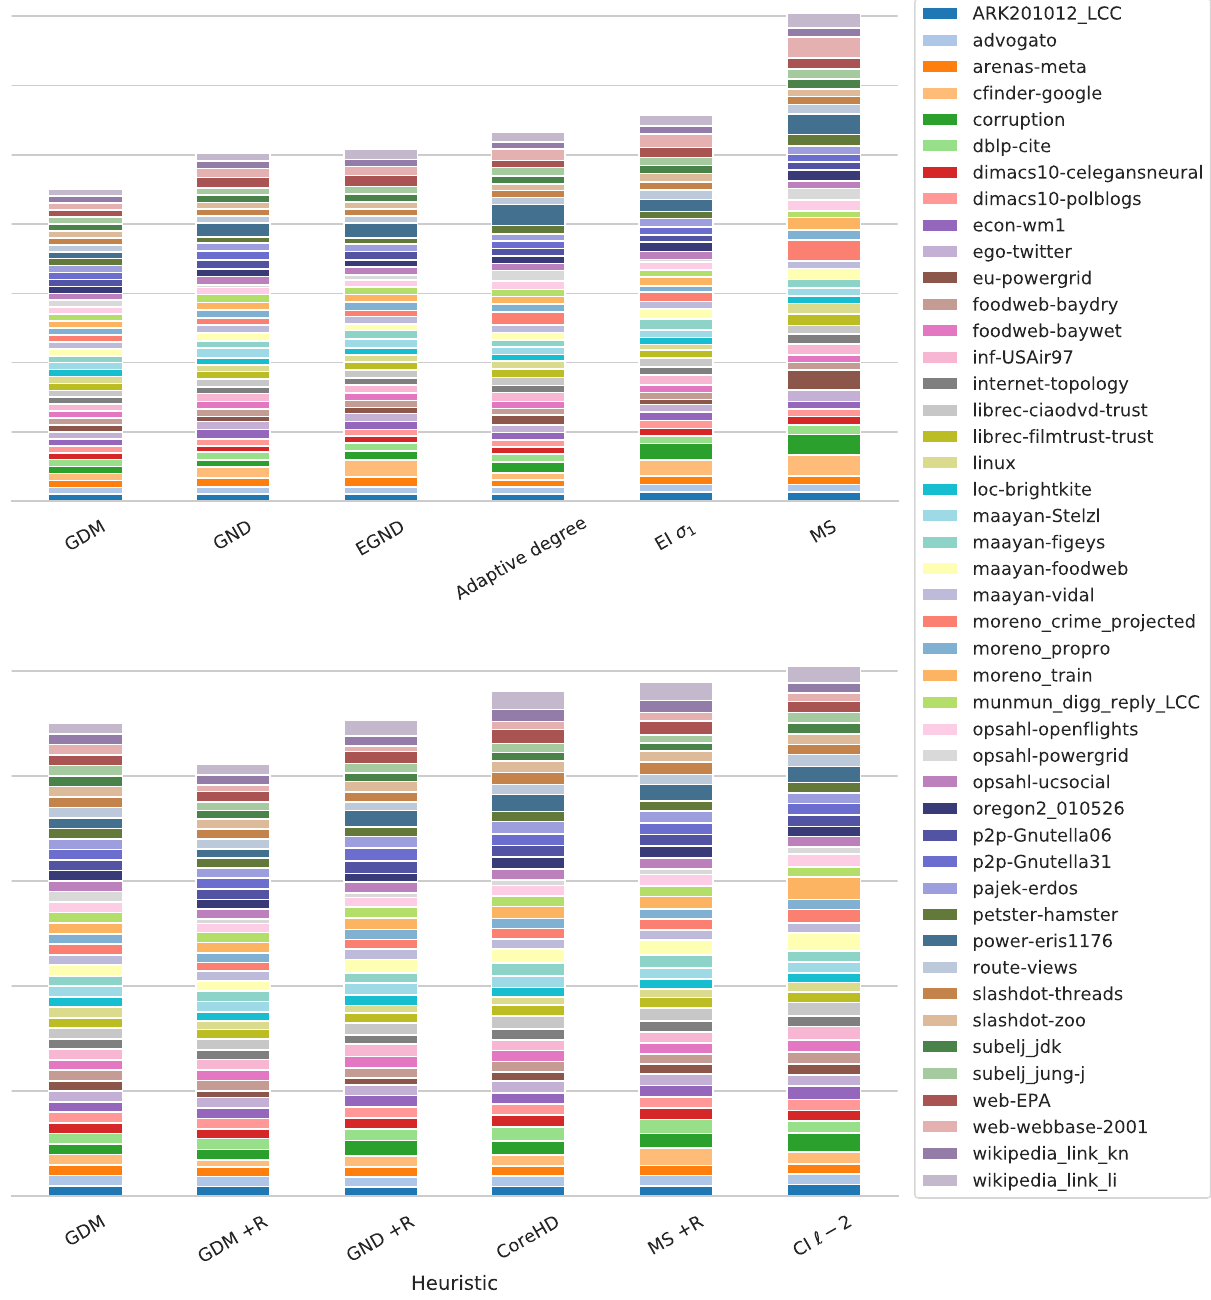
Fig. 3 Dismantling empirical complex systems. Per-method cumulative area under the curve (AUC) of real-world networks dismantling. The lower the better. The dismantling target for each method is 10% of the network size. Each value is scaled to the one of our approach (GDM) for the same network. GND stands for Generalized Network Dismantling, EGND for Ensemble approach for GND (in both GND and EGND, cost matrix W = I ), MS stands for Min-Sum, EI σ 1 stands for Explosive Immunization ( σ 1 ) algorithm and CI for Collective In fl uence. + R means that the reinsertion phase is performed. CoreHD and CI are compared to other + R algorithms as they include the reinsertion phase. Also, note that some values are clipped (limited) to 3× for the MS heuristic to improve